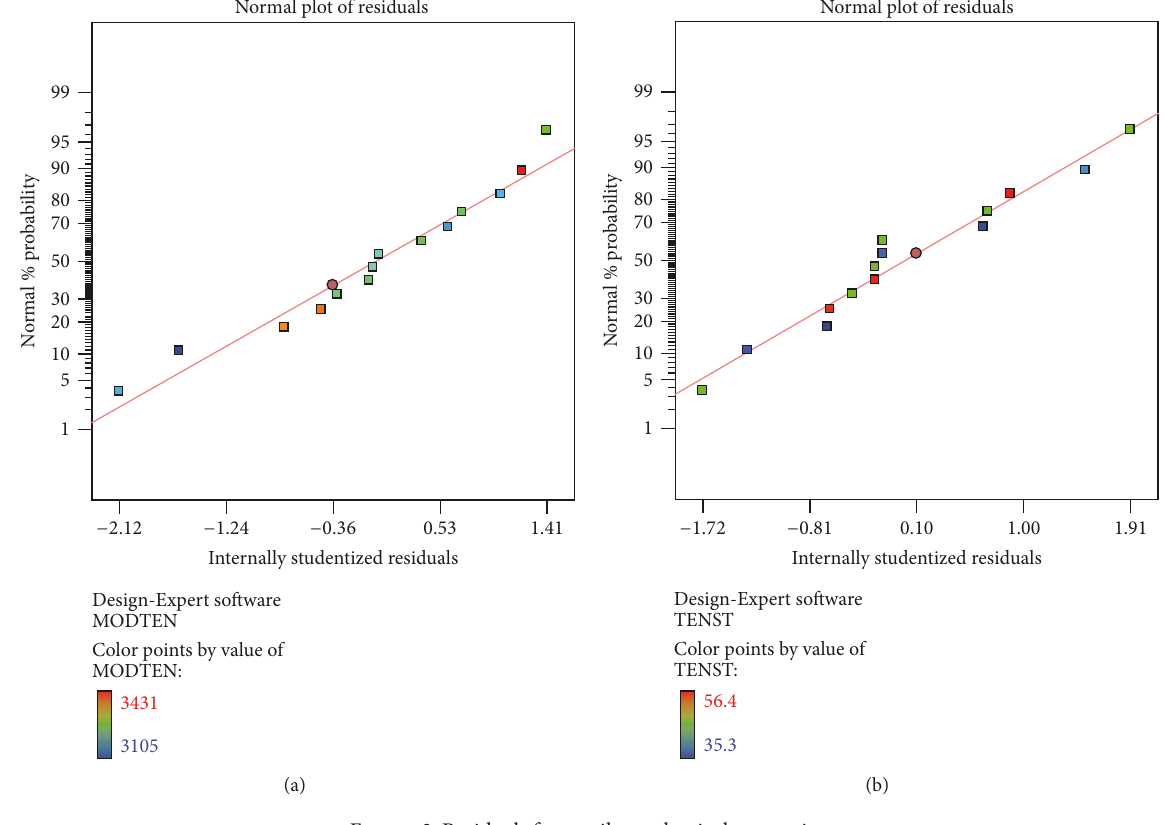
Figure 2: Residuals for tensile mechanical